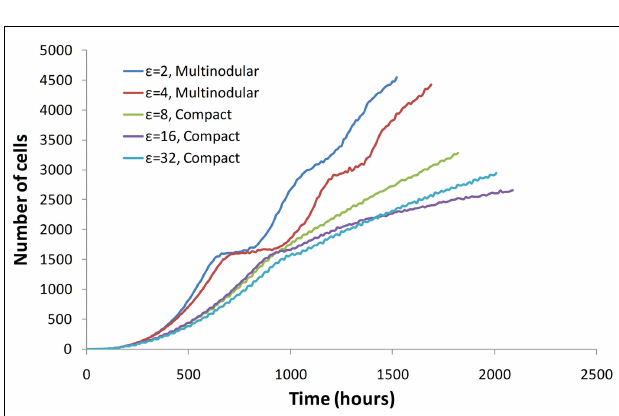
FIGURE 3 |Transition of tumor morphology from diffuse to multinodular to compact. The figure shows change in morphology upon varying the properties of cancer cells, including random cell motility ξ , cell–cell adhesion ε , and cell–ECM adhesion (friction) μ . Cells with high motility and low cell–cell